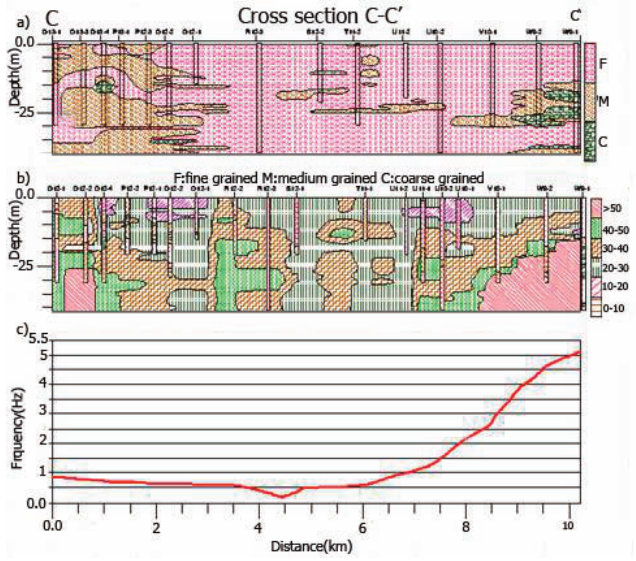
Figure 8. C-C` cross-section. Variations in the soil texture (a) N-SPT (b), and predominant frequency